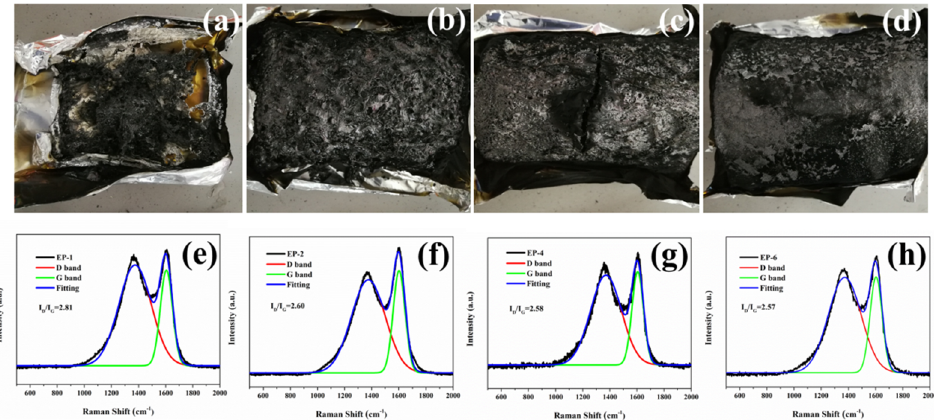
Figure 6. Photographs and Raman spectra of the char residue from pristine EP ( a , e ), EP / DOPO ( b , f ), EP / DOPO-AHPP ( c , g ), and EP-AHPP ( d , h ) after cone calorimeter tests.